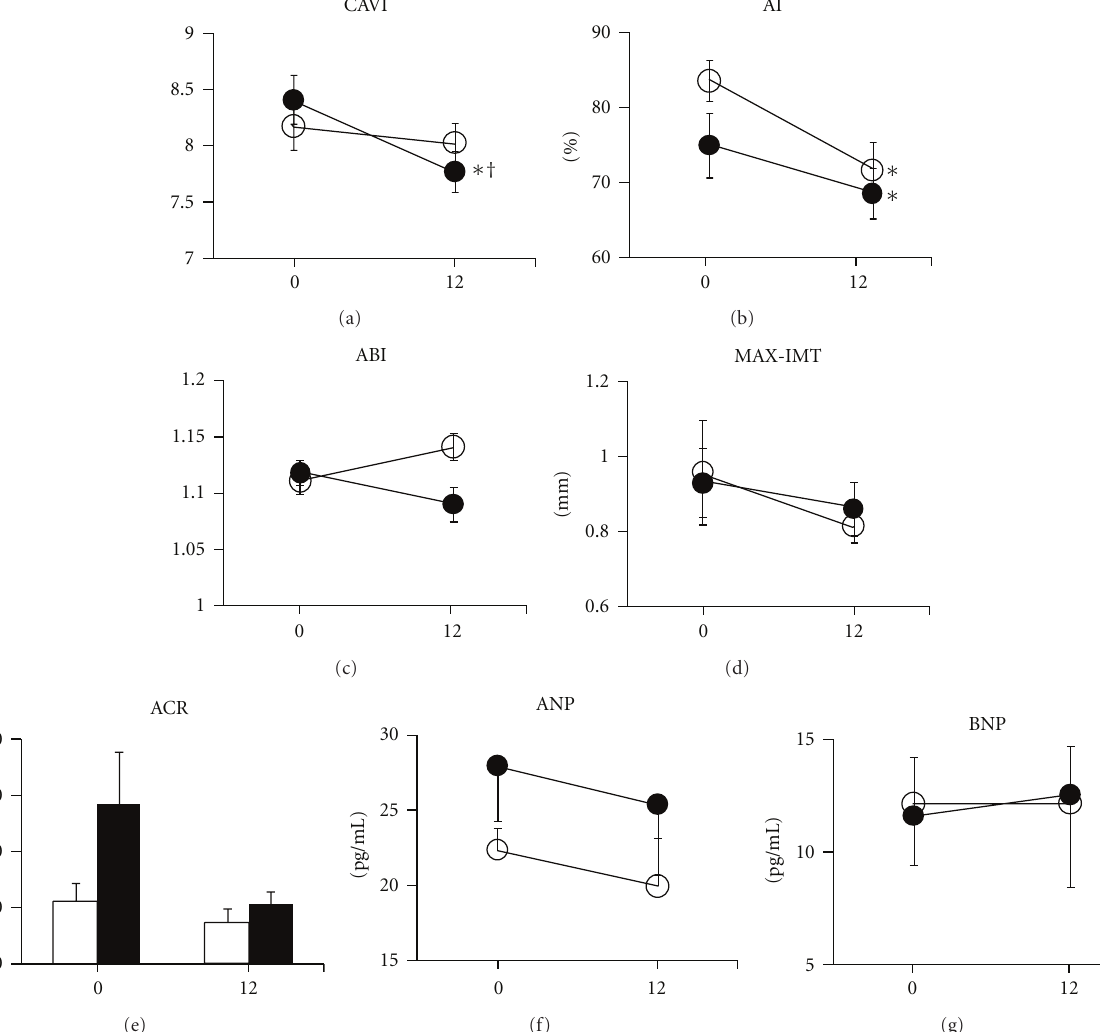
Figure 1: Cardioankle vascular index (CAVI), augmentation index (AI), ankle-brachial index (ABI), maximum of intima-media thickness (MAX-IMT), urinary albumin to creatinine ratio (ACR), serum atrial natriuretic peptide (ANP), and serum brain natriuretic peptide (BNP) at baseline and after 12 months of treatment with olmesartan monotherapy (open circles) or combination therapy with olmesartan and azelnidipine (closed circles). ∗ P < . 05 versus the baseline value. † P < . 05 versus the olmesartan